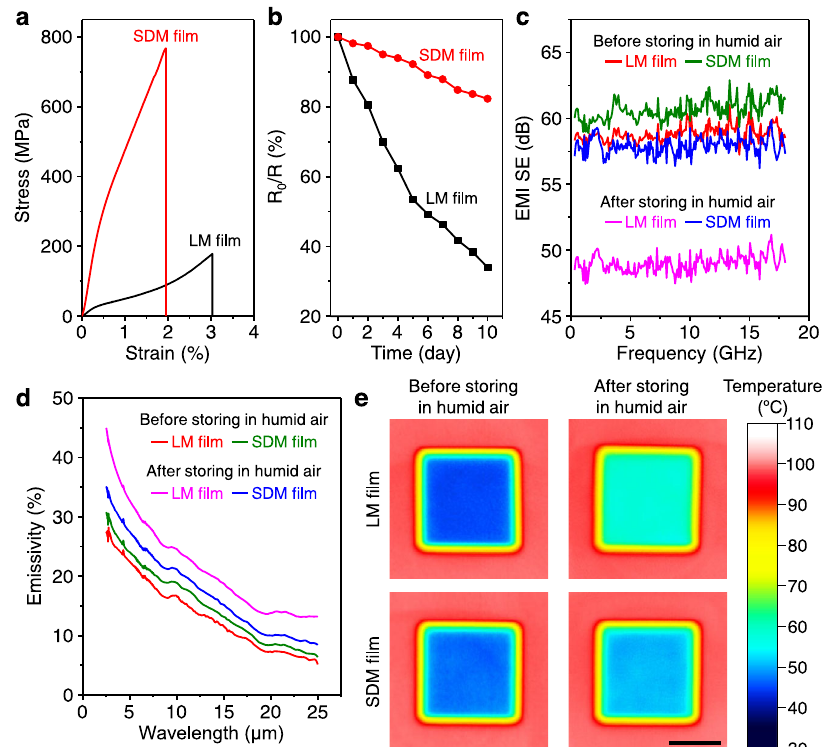
Fig.4|PropertiesofLMandSDM fi lms.a Typicaltensilestress-straincurvesofas- preparedLMandSDM fi lms. b Conductanceretentionpercentagesasafunctionof time for LM and SDM fi lms during 10 days ’ storagein humidair with 100% relative humidity. c – e EMI SE as a function of frequency ( c ), mid-IR emissivity spectra ( d ),